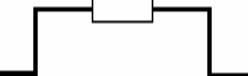
Figure 2. Experimental and fitting (EEC) Impedance (Nyquist) plots at ( a ) 303 K, ( b ) 323 K, ( c ) 343 K, and ( d ) 353 K.